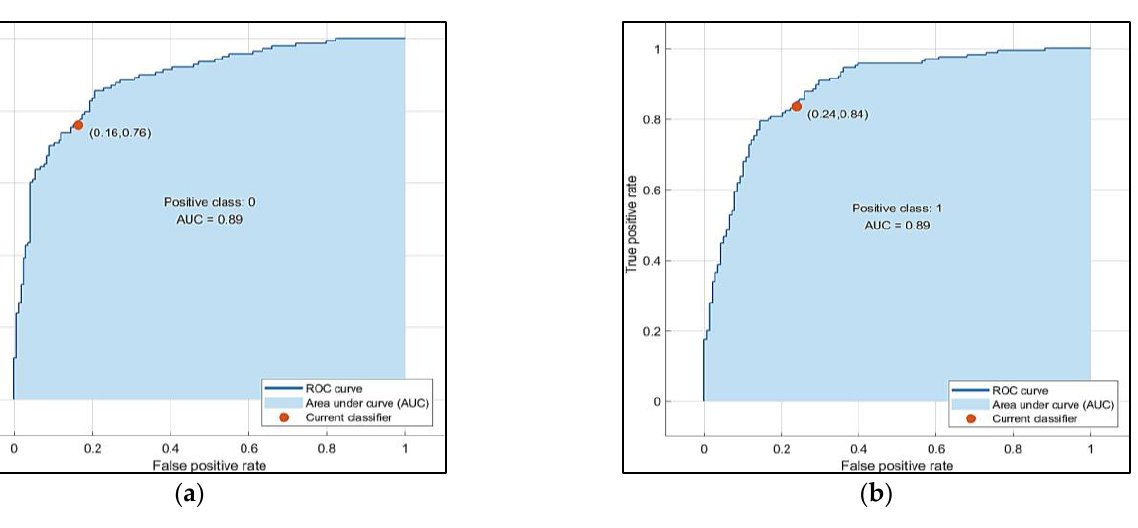
Figure 13. ( a ) LR model ROC curve corresponding to class 0 ( b ) LR model ROC curve corresponding to class 1 using the LR.